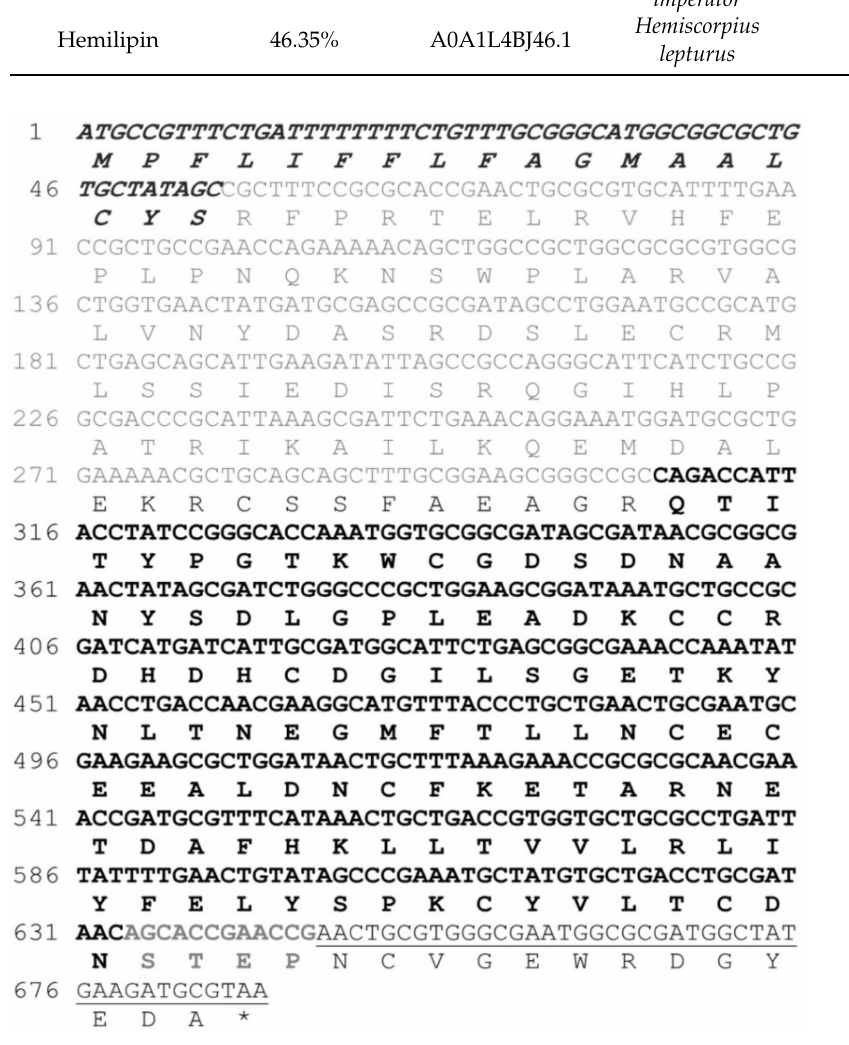
Figure 4. The amino acid and ORF sequence of leptulipin. Signal peptide: italic; propeptide: gray; mature chain: black; propeptide: gray, small subunit: underlined